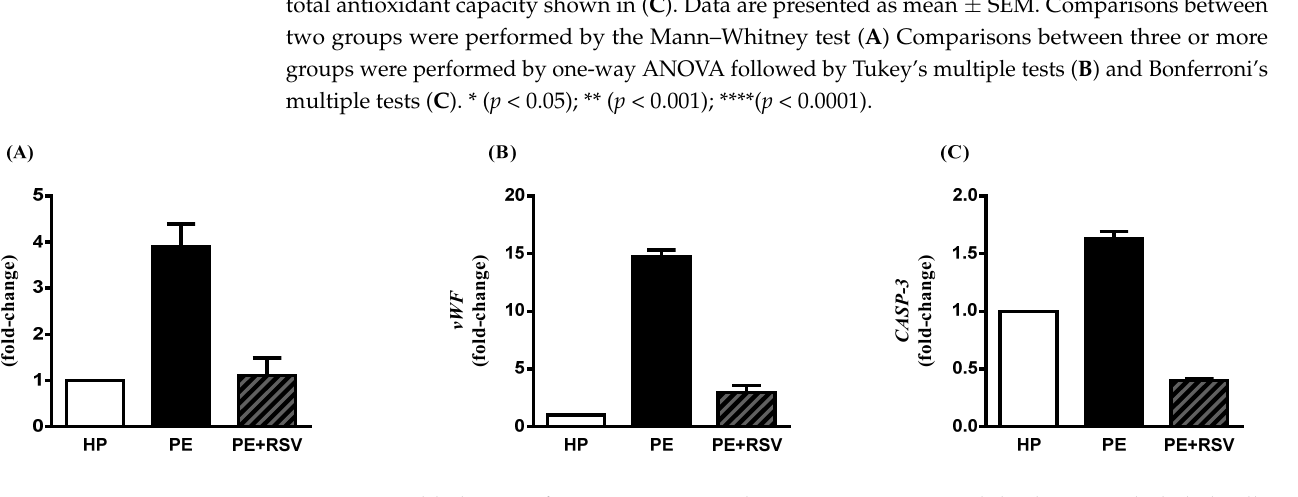
Figure 3. Fold change of ICAM-1, vWF, and CASP-3 . Human umbilical vein endothelial cells (HUVECs) were incubated with 10% ( v / v ) pooled plasma from HP ( n = 10) and PE ( n = 10) and then incubated with RSV (10 µ M) for 4 h ( A – C ). Values are presented as fold change ± SEM. Regarding vWF expression, the PE group showed higher levels when compared with the endothelial cells incubated with HP plasma ( p > 0.0001 and fold change > 2.0) (Figure